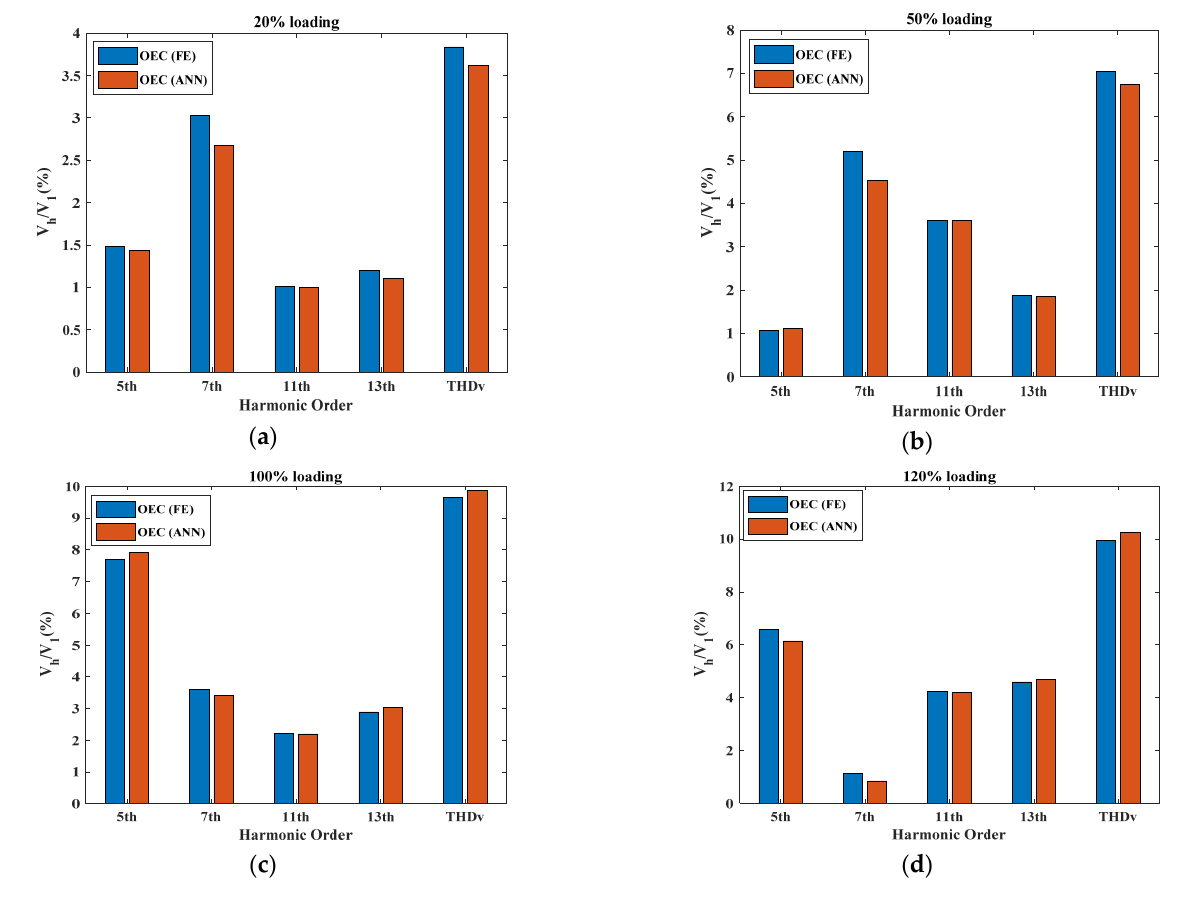
Figure 13. Individual and total harmonic distortions of the terminal line voltages obtained via the proposed (ANN) and FE model under ( a ) low (20%), ( b ) semi (50%), ( c ) full (100%) and ( d ) over (120%) loading levels for optimally modulated excitation current cases.